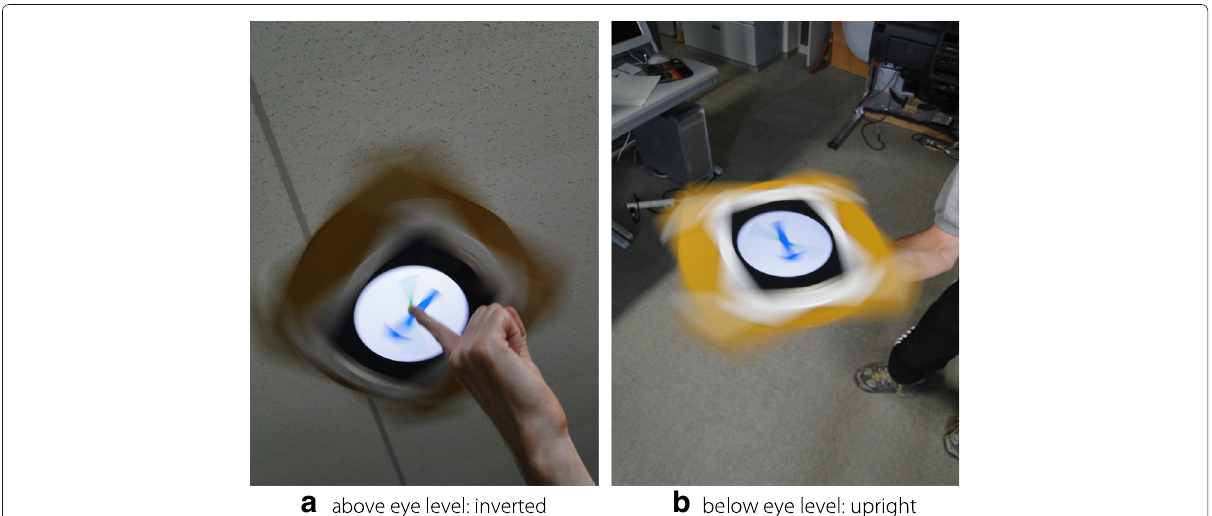
a b Fig. 2 Double-headed (“two-faced”) padiddle configuration, allowing viewing both above and below eye level. (a)bove eye level: inverted. (b)elow eye level: upright avatar’s head. Such intimacy can be described as endocen- tric, centered within a subject, and is sometimes impre- cisely refered to as a “PoV” (point-of-view)